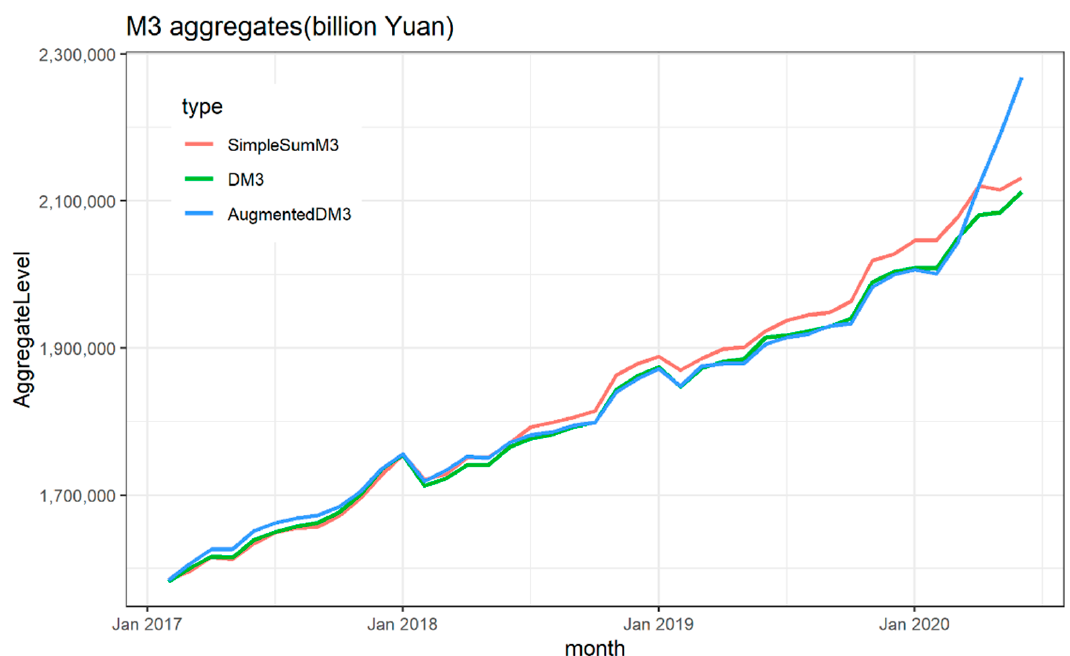
Figure 3. Divisia M2, Consumption Loan Augmented M2 and simple sum M2.